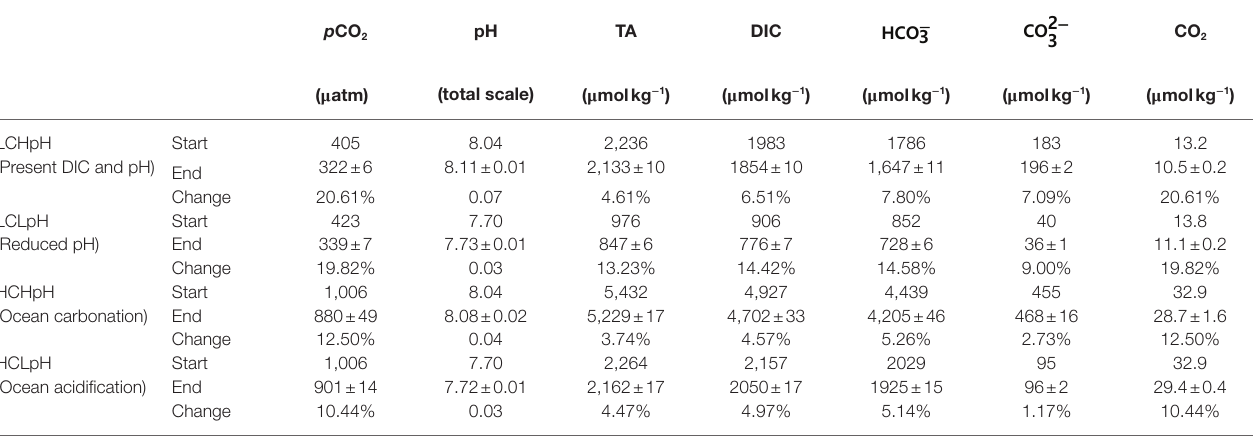
TABLE 1 | Carbonate chemistry parameters at the start and end of the incubation, and changes in carbonate chemistry parameters during the incubation.